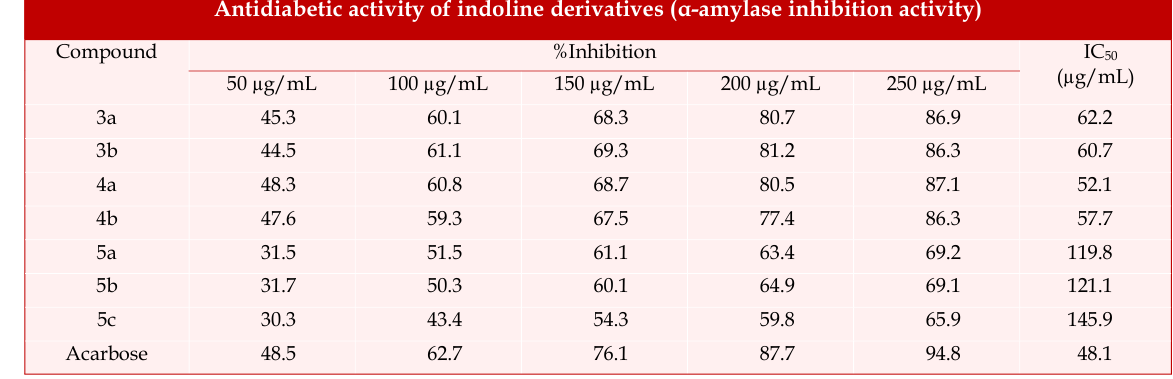
Antidiabetic activity of indoline derivatives ( α - amylase inhibition activity)